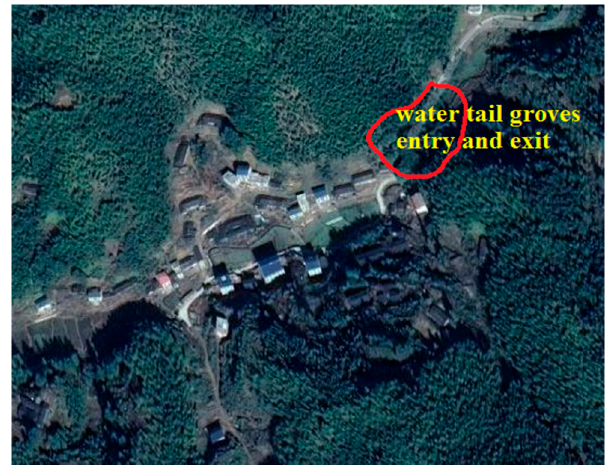
Figure A5. Geographical features of Kengtou Village.